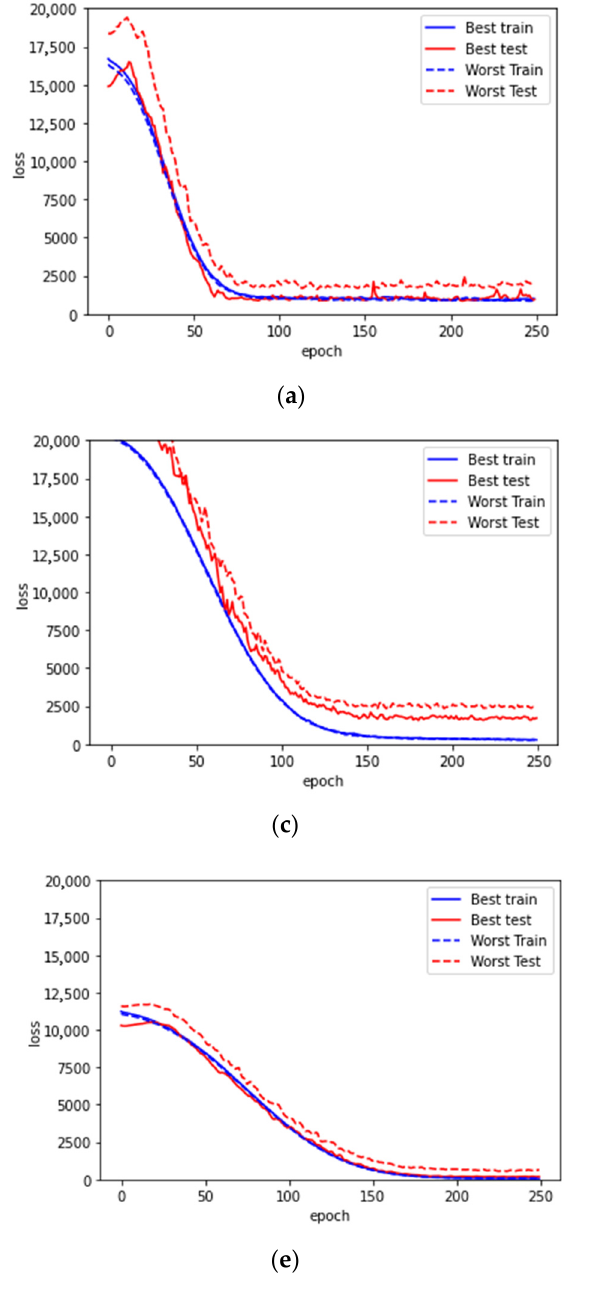
Figure 5. Learning curves for ( a ) model with all subjects and without HbA1c, ( b ) model with all subjects and with HbA1c, ( c ) model with medication, ( d ) model with medication and with HbA1c, ( e ) model without medication, ( f ) model without medication and with HbA1c. In each case, the best and worst trainings among the 10 trainings are presented. Both the best and the worst testing cases among the 10 trainings in each model are presented.